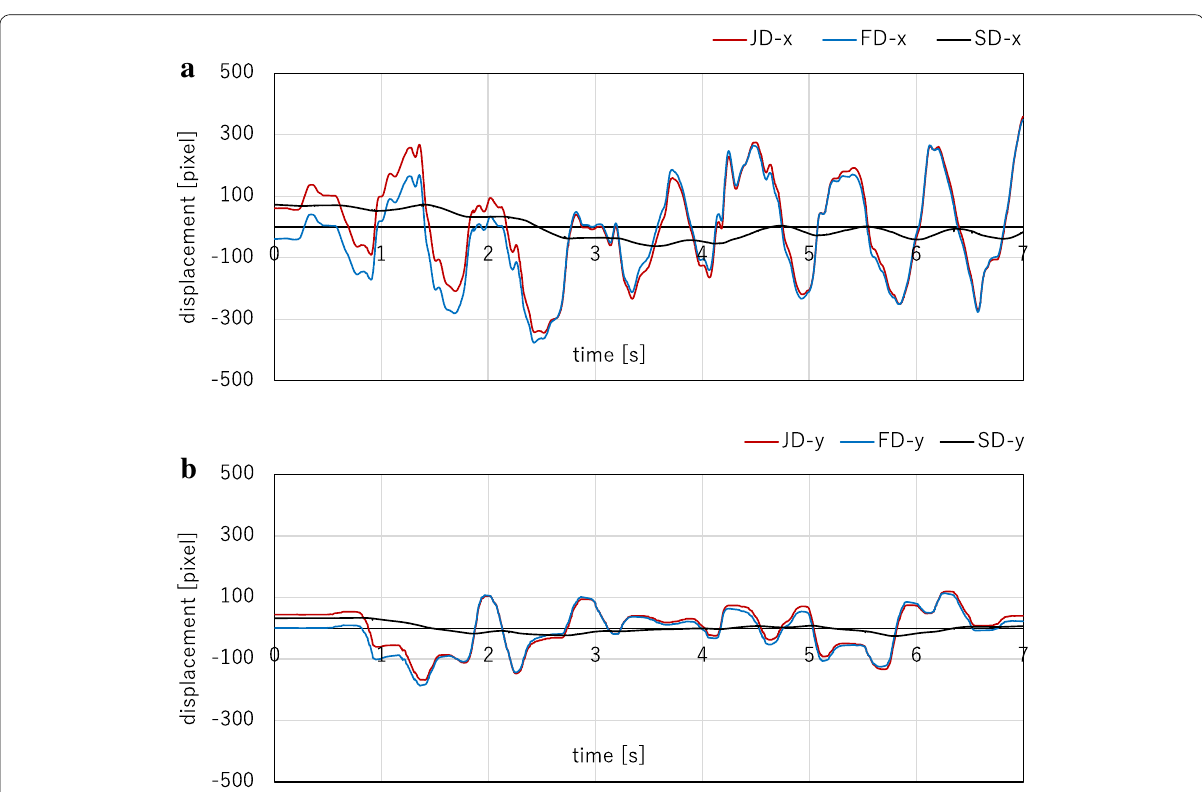
Fig. 14 Jitter displacement (JD), filtered high-frequency component (HD), and stabilized displacement (SD) in outdoor stair experiment a horizontal displacements, b vertical